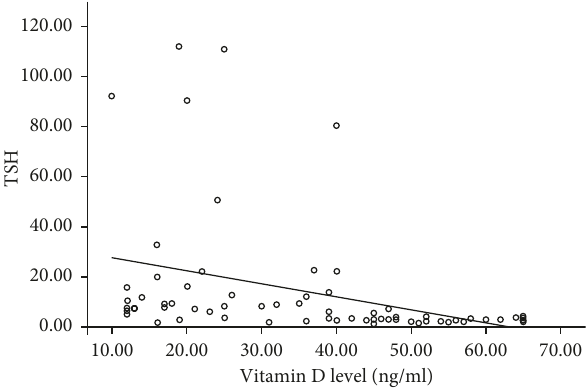
Figure 1: Relation of vitamin D levels with different TSH